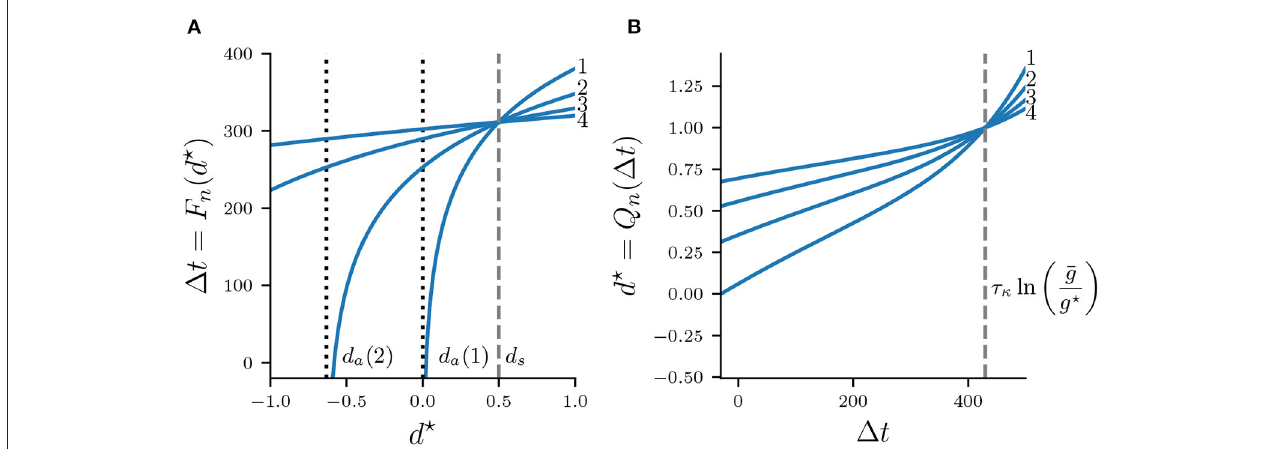
FIGURE 7 | Maps F n (A) and Q n (B) for ¯ g = 0.5 mS / cm 2 and n = 1,2,3,4. Curves F n intersect at d ⋆ = d s which is indicated by a dashed vertical line. Curves Q n